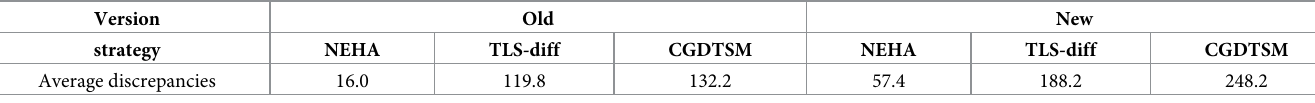
Table 2. The average discrepancies of the old and new versions based on the three methods. Version